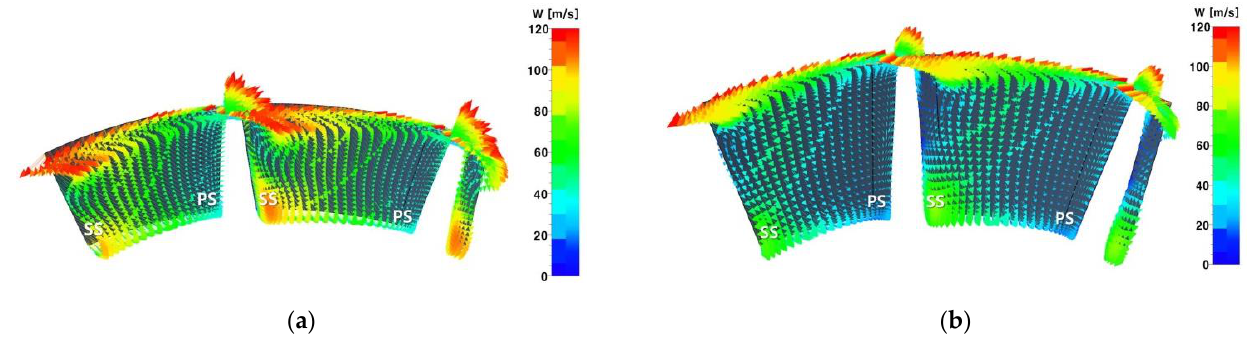
Figure 18. Comparison of relative velocity distribution at Plane 2: ( a ) original model and ( b ) opti- mized model.